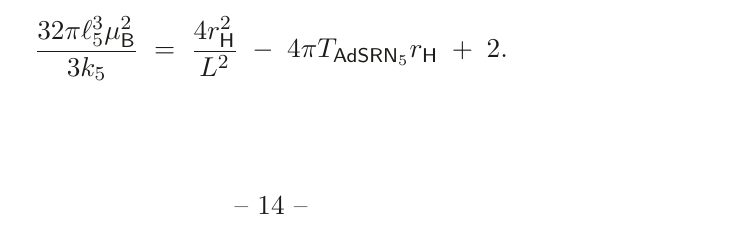
JHEP02(2023)072